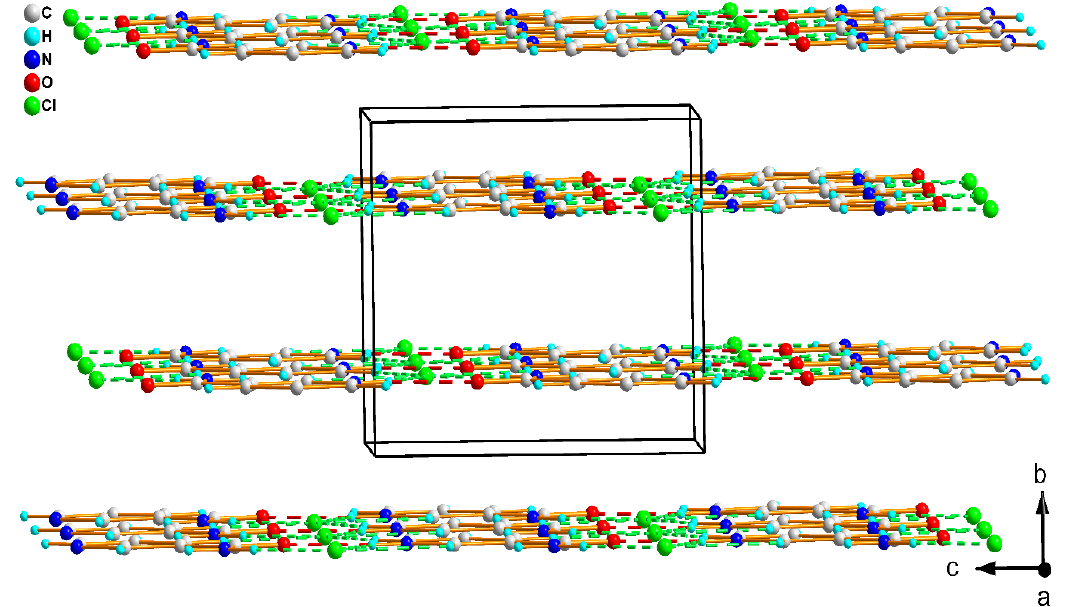
Figure 2. Autostereogram of (C 6 H 7 N 2 O) + ·Cl - showing a 2D-layers stacked along the b -axis.